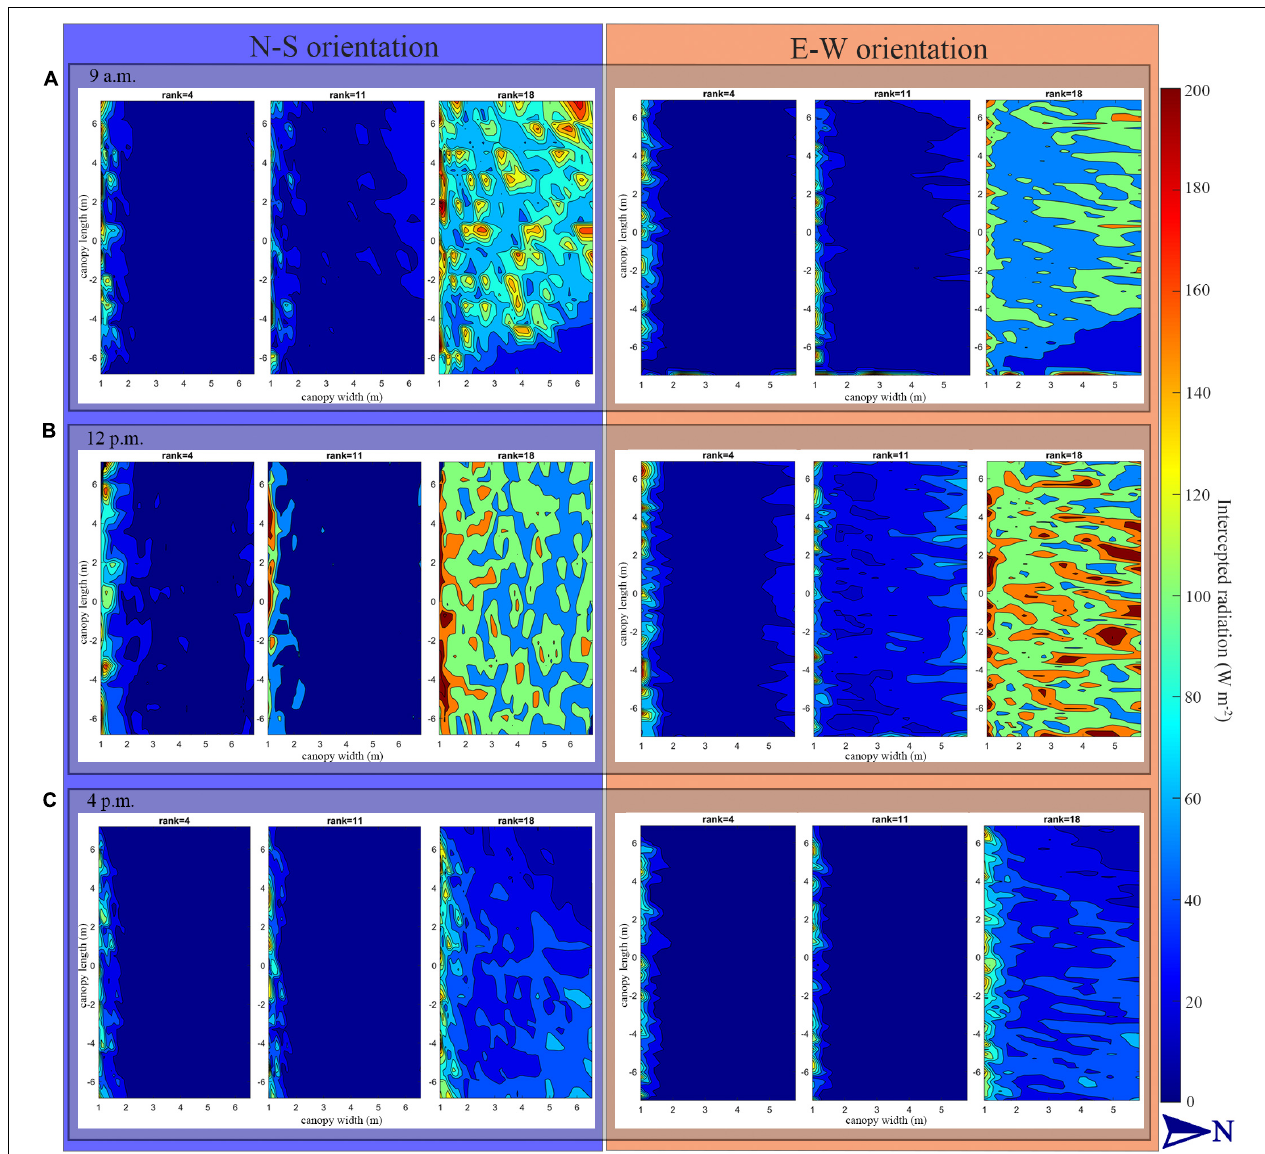
FIGURE 9 | Heat map of intercepted solar radiation of tomato canopy at lower (rank = 4), middle (rank = 11) and upper layer (rank = 18) at 9:00 a.m. (A) , 12:00 p.m. (B) , and 4:00 p.m. (C) under N–S orientation and E–W orientation of planting pattern 4 (incrementing